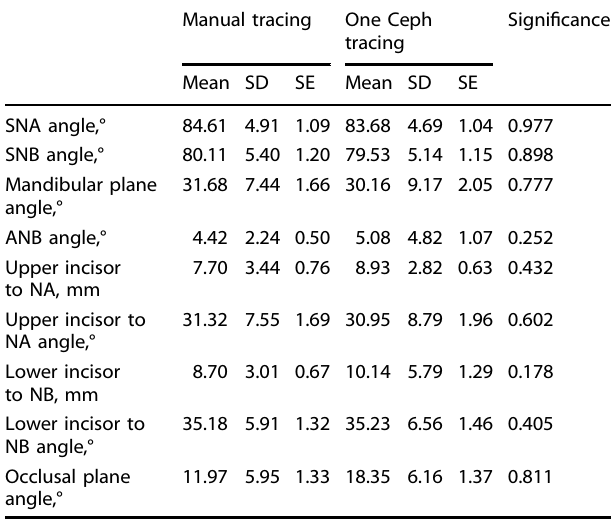
Table 1. The bar graph represents the mean, standard deviation, and standard error of manual tracing and OneCeph tracing for a con fi dence interval of 95% for the parameters of Steiner ’ s